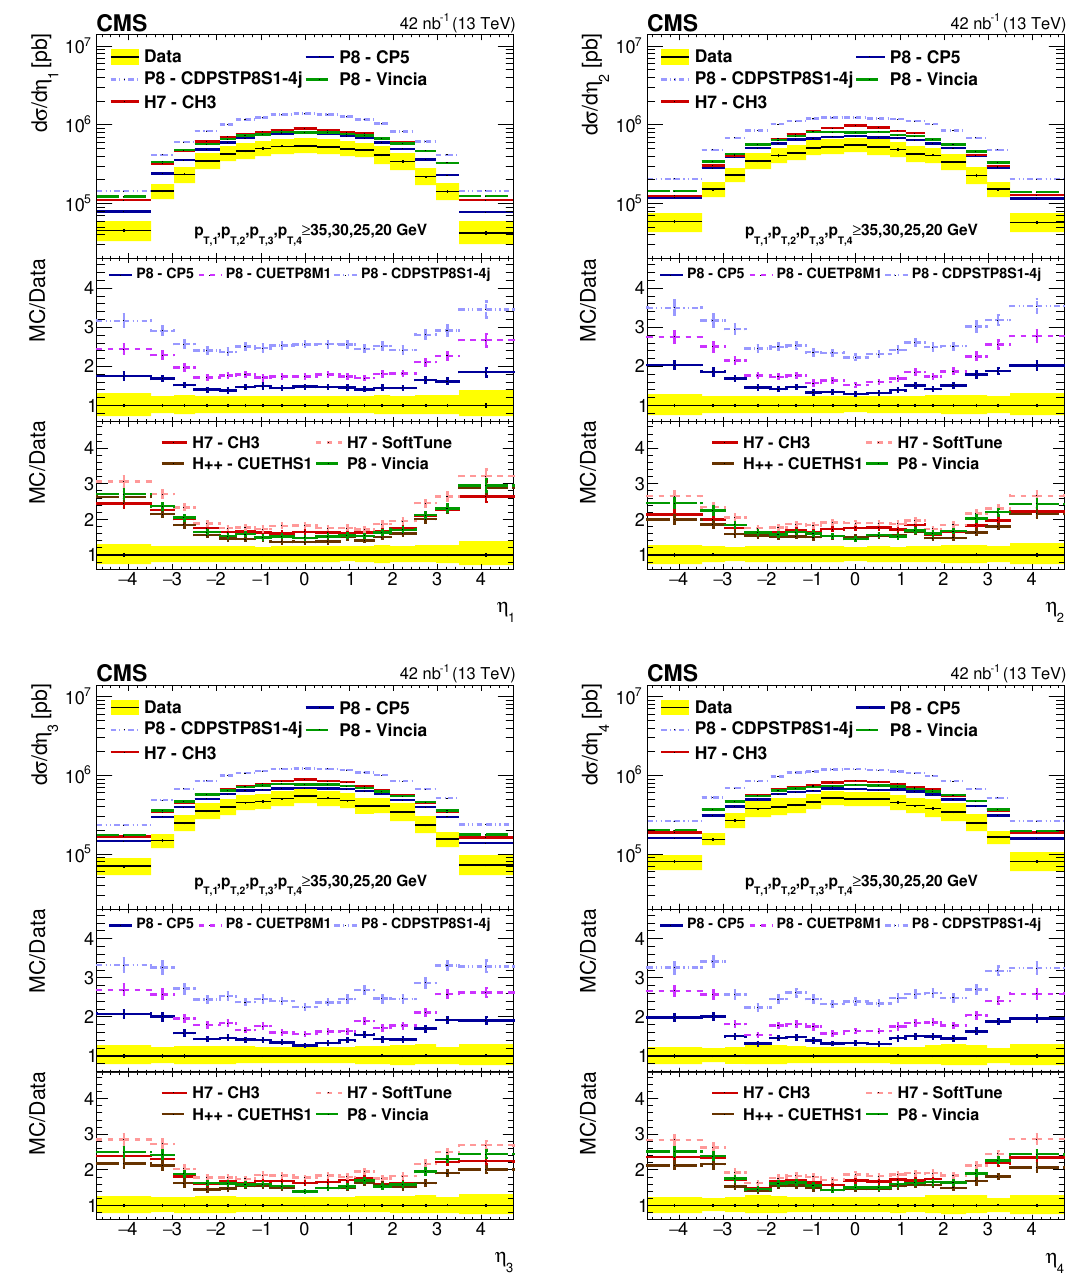
Figure 3 . Comparison of the η spectra from data to different pythia 8 (P8), herwig++ (H++), and herwig 7 (H7) tunes, for the leading (upper left), subleading (upper right), third leading (lower left), and fourth leading (lower right) jet in Region I. The error bars represent the statistical uncertainty, and the yellow band indicates the total (statistical+systematic) uncertainty in the